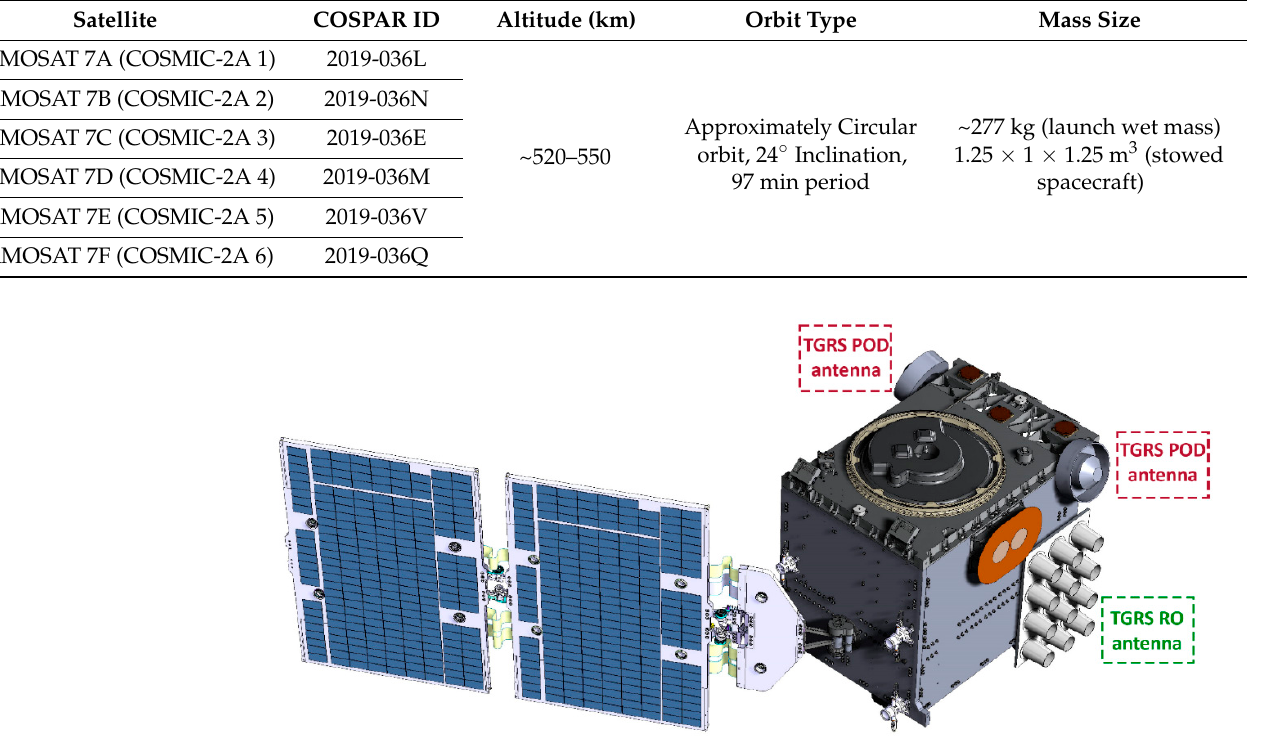
Figure 11. COSMIC-2 satellite structure (credit: Surrey Satellite Technology).